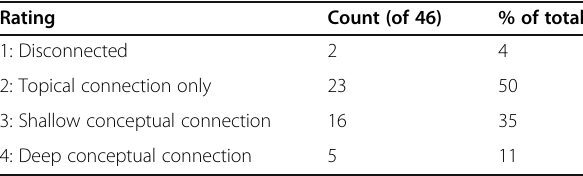
Table 6 Ratings of science-engineering connection assigned to unit plans